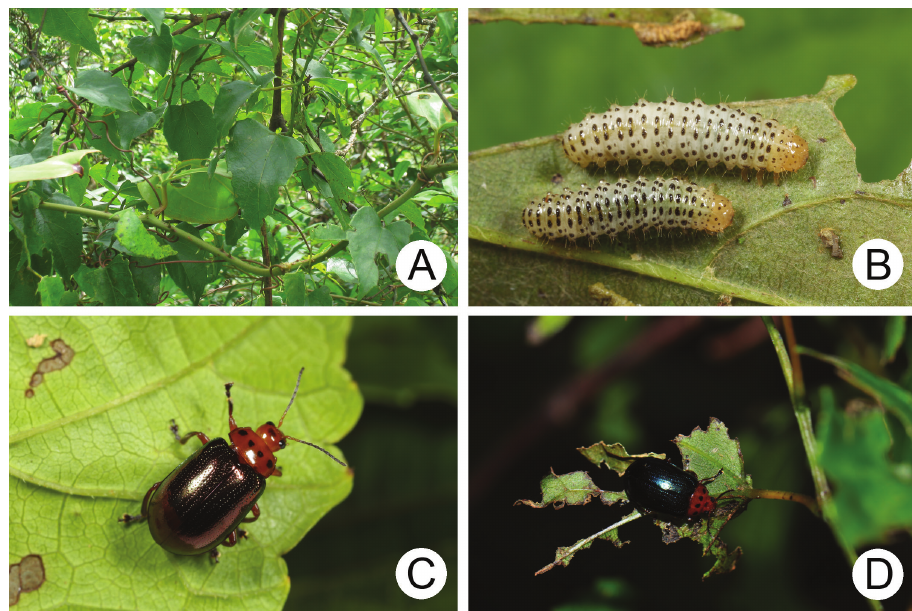
Figures 15. Field photographs of Gallerucida thoracica (Jacoby). A Host plant: Vitis flexuosa B Larvae C Adult, metallic bronze form D Adult, metallic blue form.